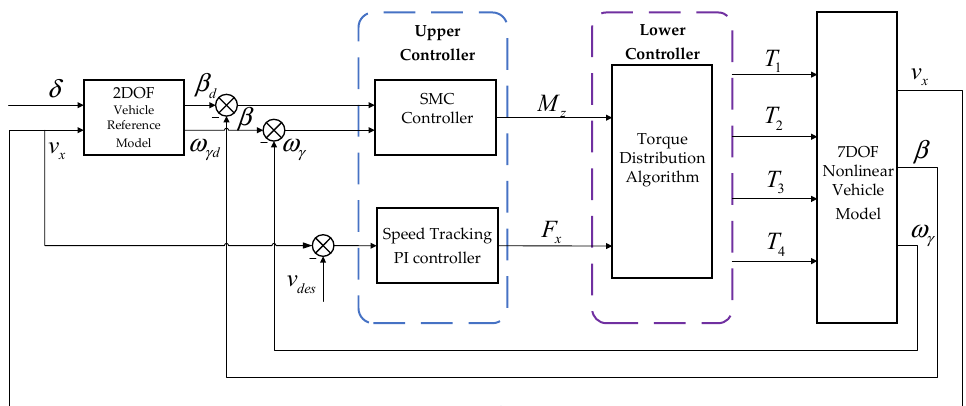
Figure 4. The schematic of the proposed control scheme.